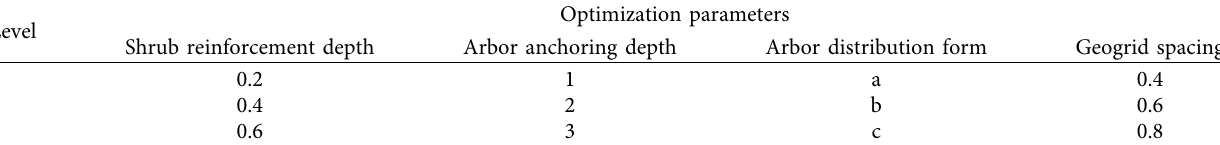
Table 3: Orthogonal design level of optimized parameters (unit: